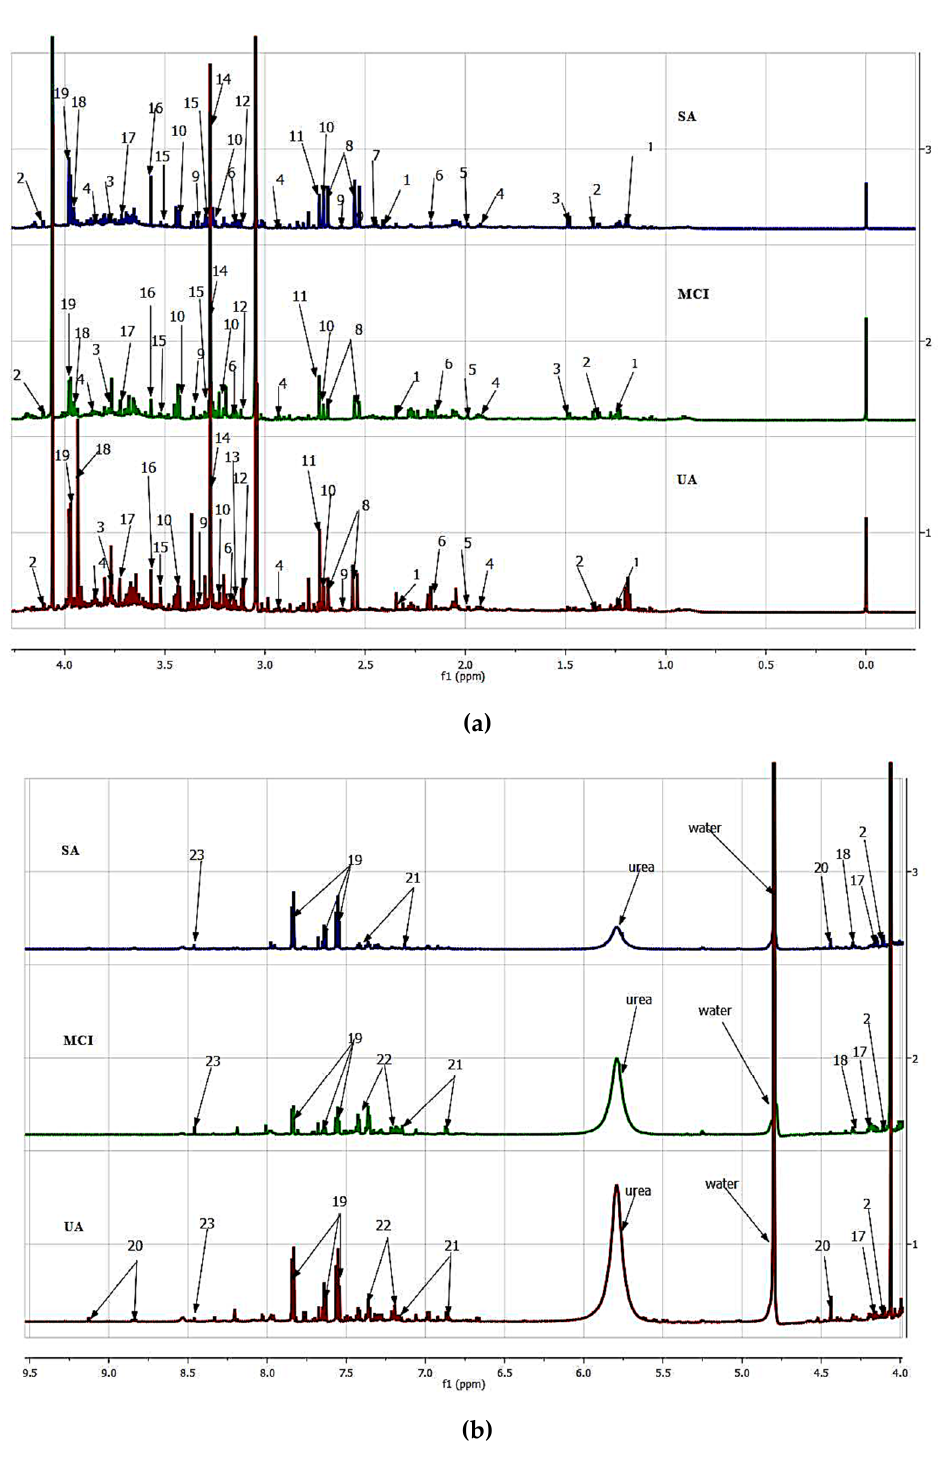
Figure 1. 1 H-NMR spectra (600 MHz) of urine in PBS for successful aging (SA), mild cognitive impairment (MCI), and usual aging (UA) representatives. ( a ) 0.0 to 4.0 ppm ( b ) 4.0 to 9.5 ppm. Putative identified metabolites for urine: (1) 3-Hydroxyisovalerate, (2) Lactate, (3) Alanine, (4) Melatonin, (5) Acetate, (6) O -acetylcarnitine, (7) Succinate, (8) Citrate, (9) Hypotaurine, (10) Taurine, (11) Malate, (12) Serotonin, (13) Dimethylsulphone, (14) Trimethylamine- N -oxide, (15) Ca ff ein, (16) Glycine, (17) Kynurenine, (18) Galactarate, (19) Hippurate, (20) Trigonelline, (21) 4-Hydroxyphenyllactate, (22) Tryptophan, (23) Formate.